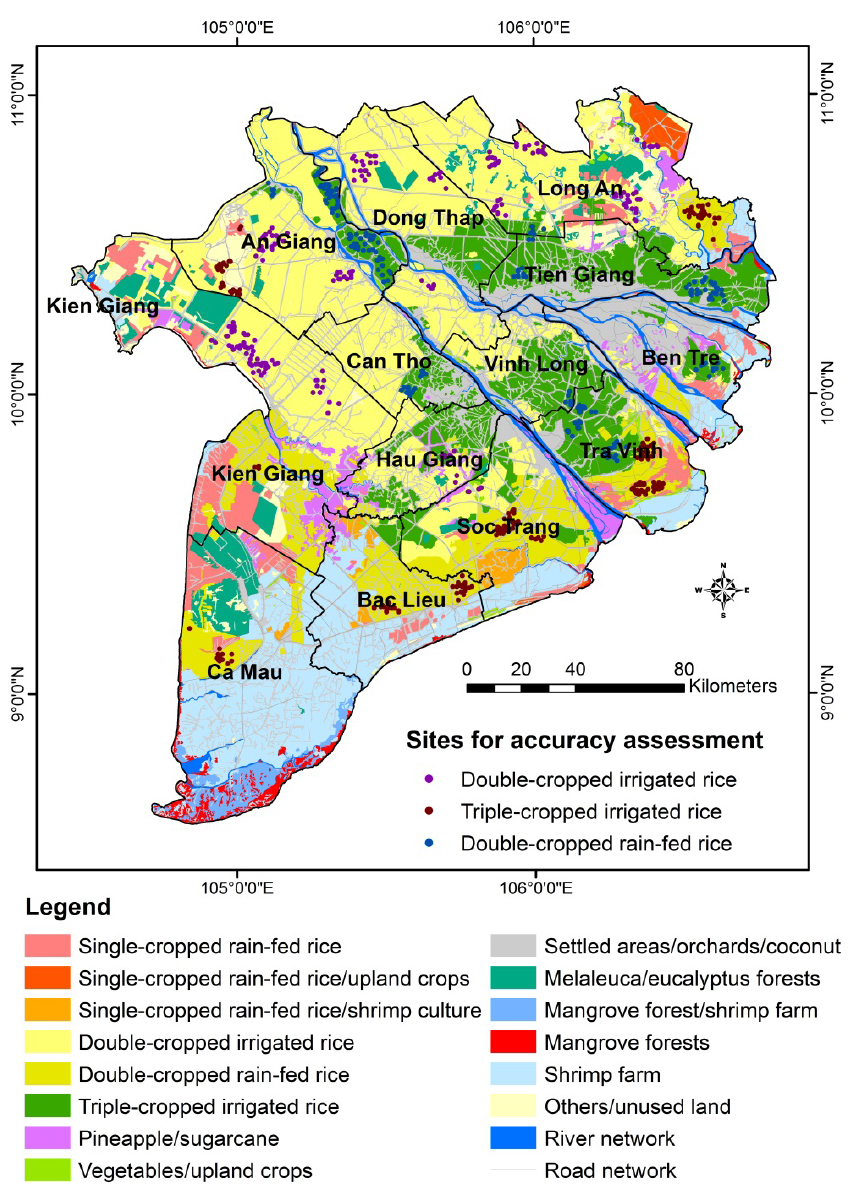
Figure 1. The 2002 land-cover map of the study area showing different rice cropping systems and the locations of sampling sites used for the accuracy assessment of the classification